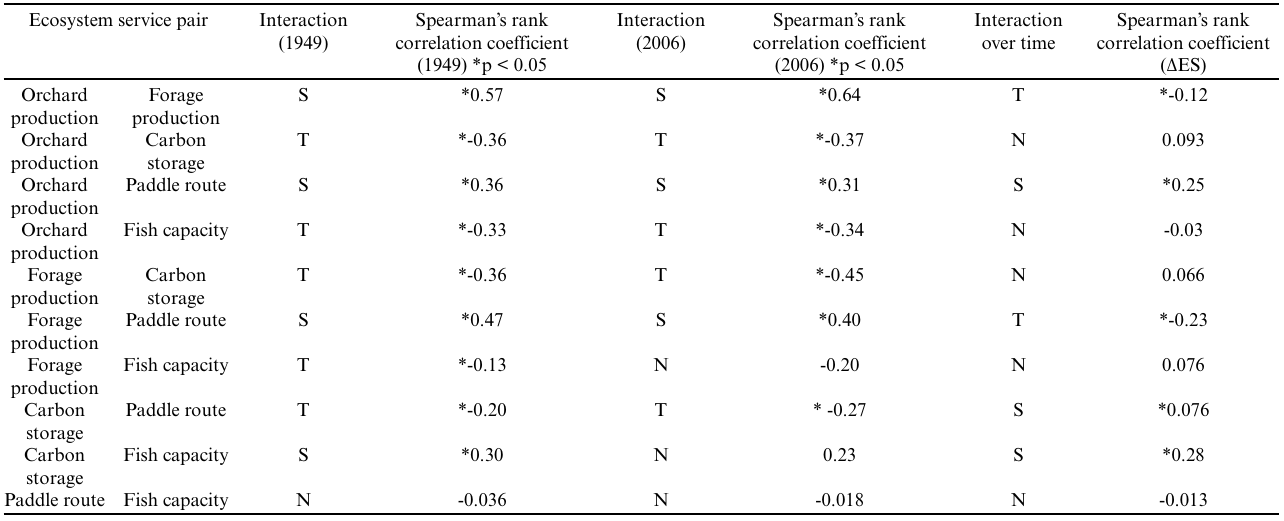
Table 3 . Types of interactions identified using two mapping methods: space-for-time substitution (at both 1949 and 2006) and change- over-time (∆ES). Pairwise Spearman’s rank correlation result. T—Trade-off, S—Synergy, N—No interaction. *Significant at 0.05. Ecosystem service pair